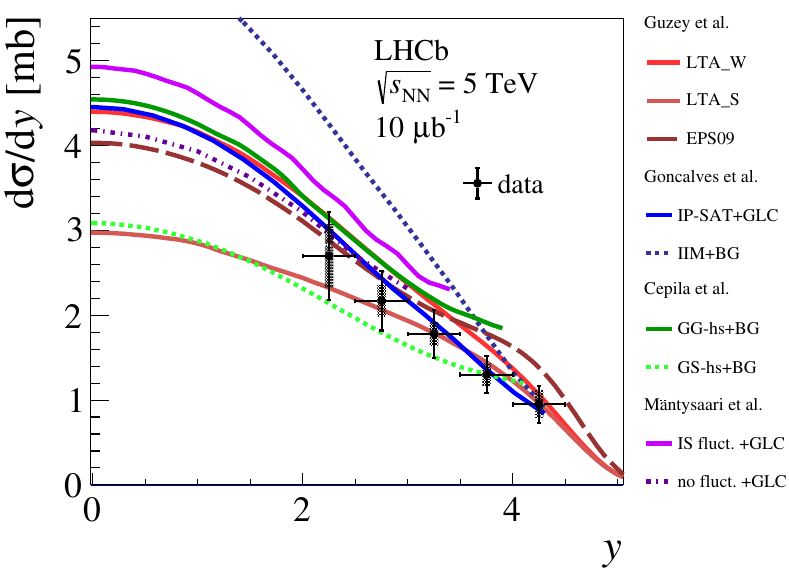
Figure 4 . Differential cross-section as a function of rapidity for coherent J/ψ production compared to different phenomenological predictions [1, 4, 36, 41, 42]. The measurements are shown as points, where inner and outer error bars represent the statistical and the total uncertainties,